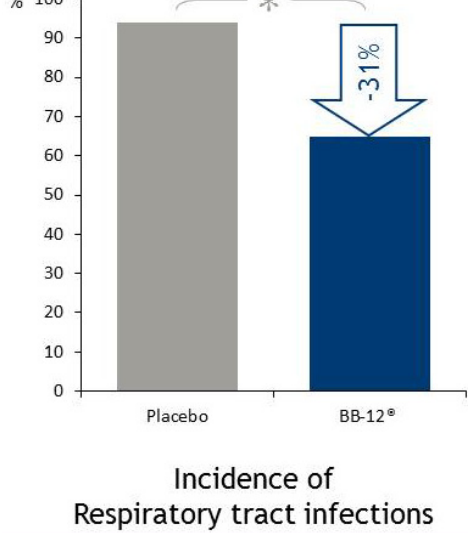
Figure 5. BB-12 ® reduced the risk of respiratory tract infections in a study by Taipale et al . 2011 [42]. In this randomized, double-blind, placebo-controlled BB-12 ® was administered using a slow-release tablet in a pacifier. Reproduced from Taipale et al . 2011 [42] with permission of Cambridge University Press, Copyright